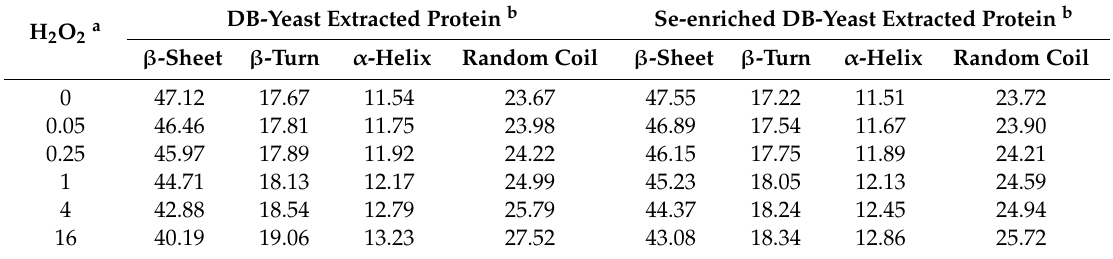
Table 2. The secondary structure composition of extracted proteins from DB-yeast and Se-enriched DB-yeast after treatment with H 2 O 2 .